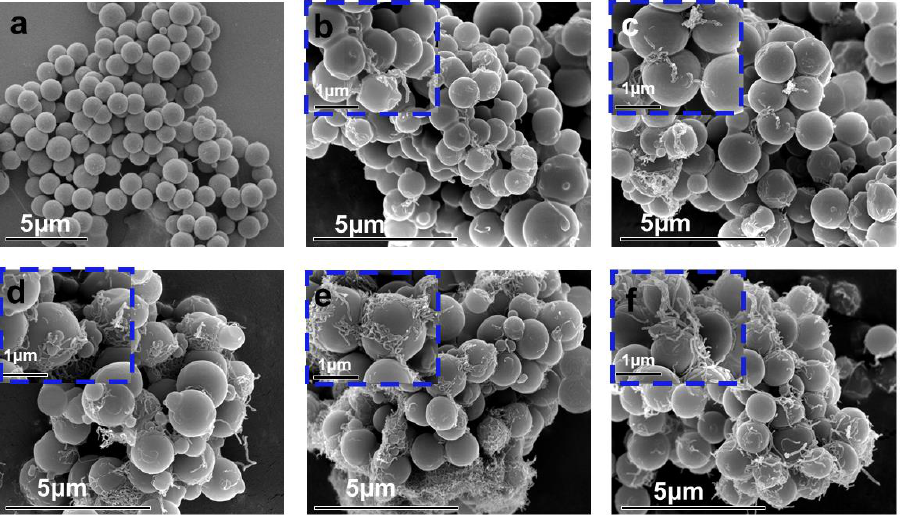
Figure 2. SEM images of ( a ) PS spheres, ( b ) PAC1, ( c ) PAC2, ( d ) PAC4, ( e ) PAC7, and ( f ) PAC10 before hot-pressing.